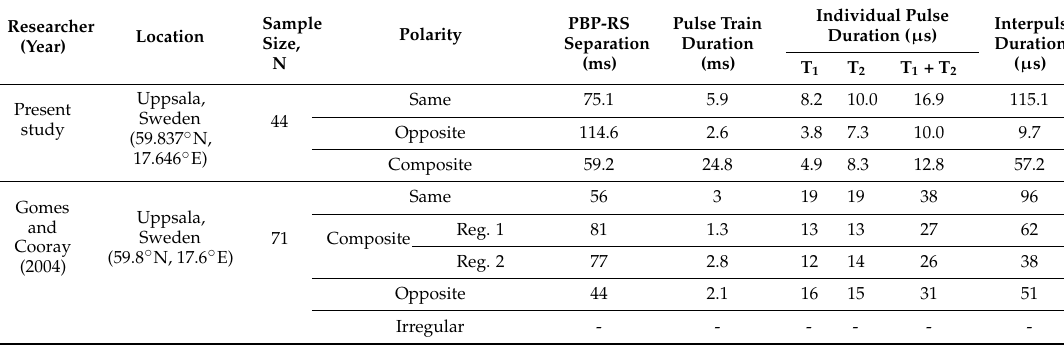
Table 5. Comparison of PBP temporal characteristics with previous